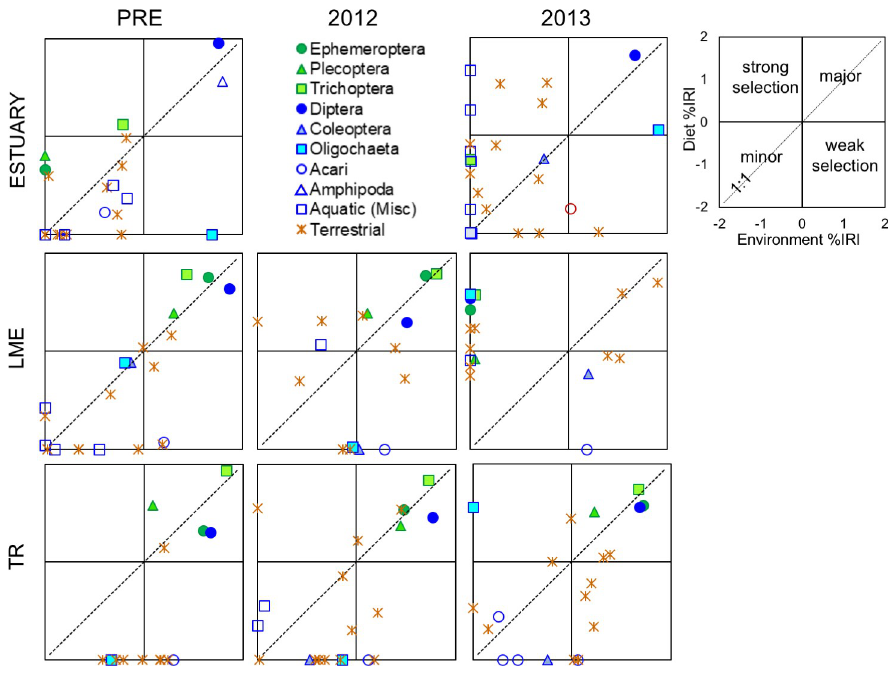
Fig 10. Index of Relative Importance (% IRI) for invertebrates present in spring environmental (x-axis) and diet (y-axis) samples. Data are log 10 transformed (i.e., 0.1% = - 2, 100% = + 2), and plotted by study section and year. Each terrestrial data point represents a different order. Orders that contributed < 0.1% to IRI are plotted at -2. Graphs do not include taxa consumed by fish but not present in environmental samples (i.e., plankton in the estuary, and fish in estuary and